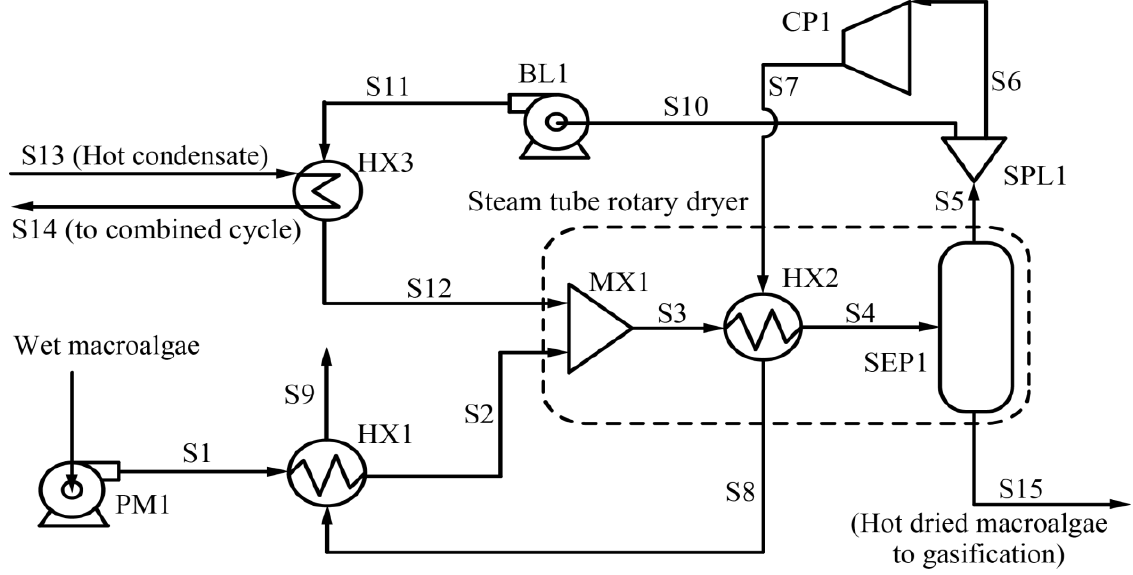
Figure 3. Process flow diagram of drying module in the proposed